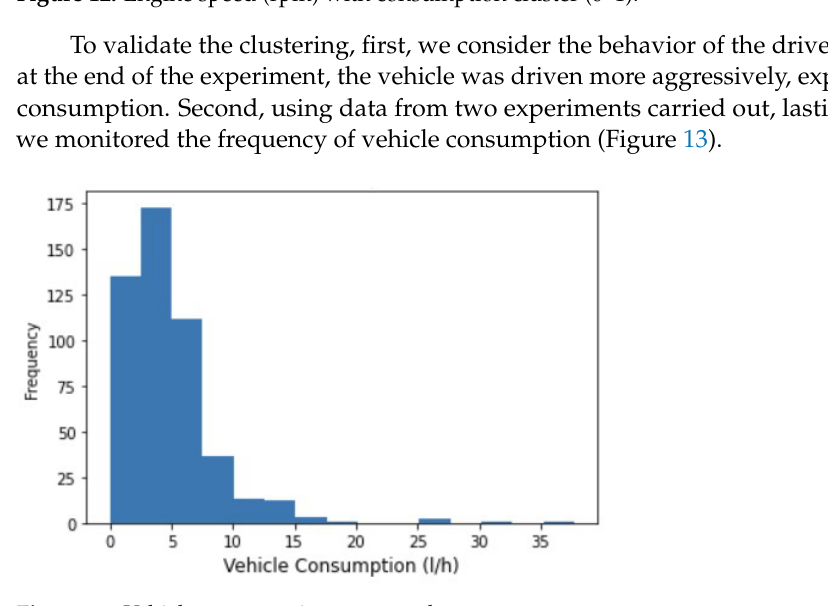
Figure 13. Vehicle consumption